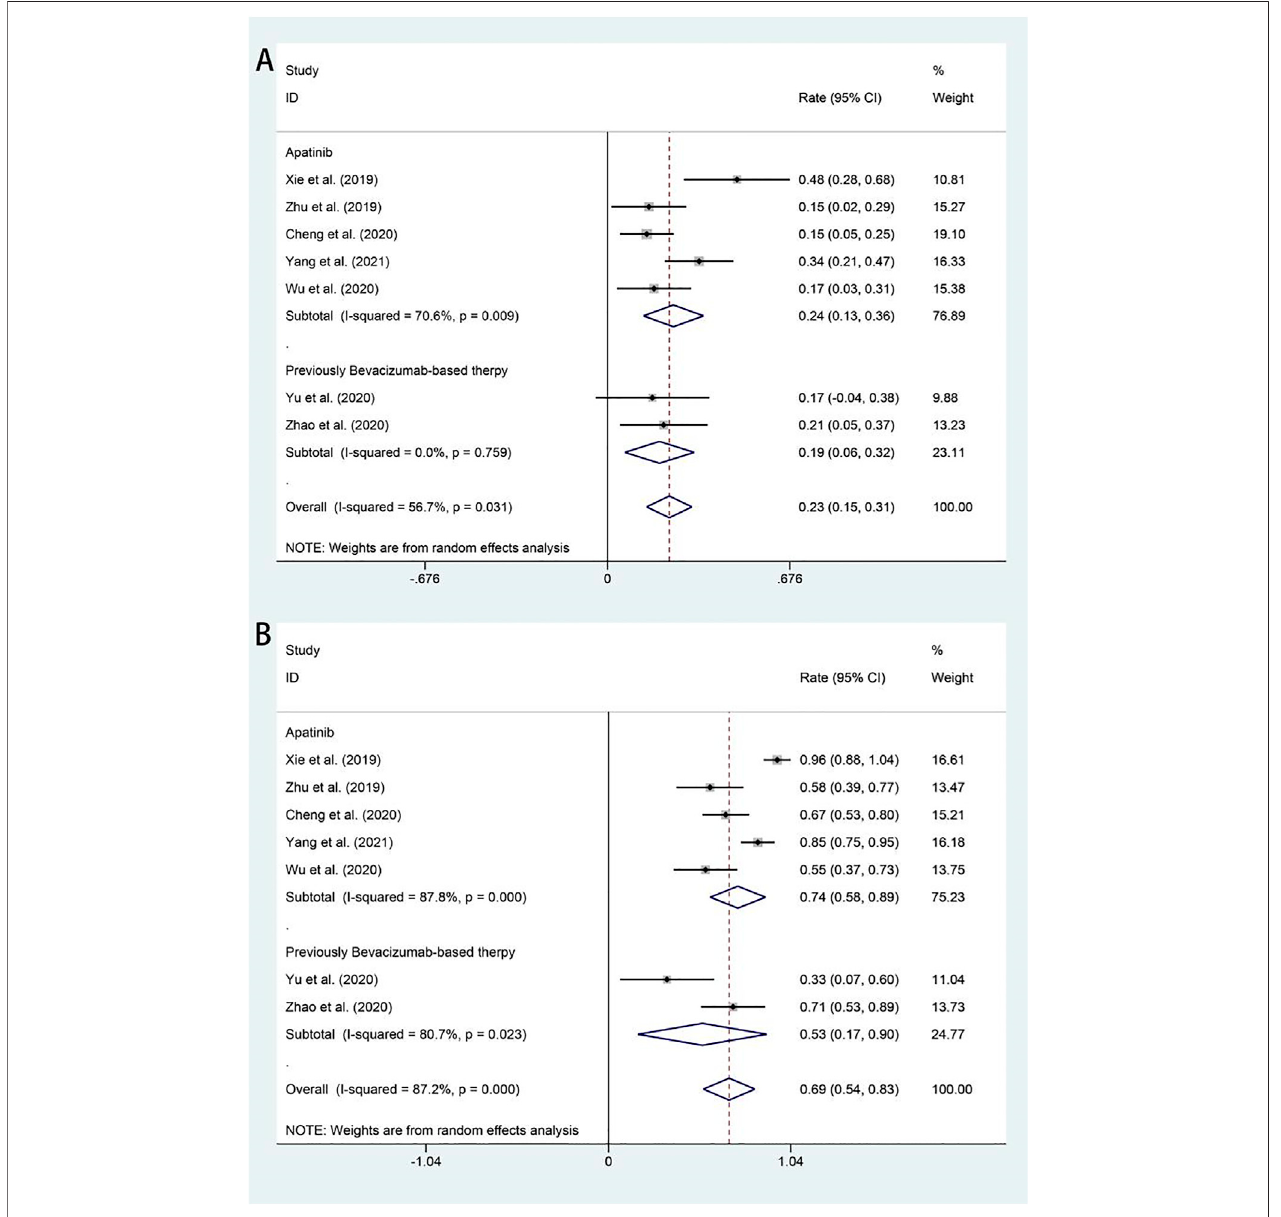
FIGURE 2 | Forest plot about the pooled results of ORR (A) and DCR (B) in total by the treatment regimen subgroup. ORR, overall response rate; DCR, disease control rate.